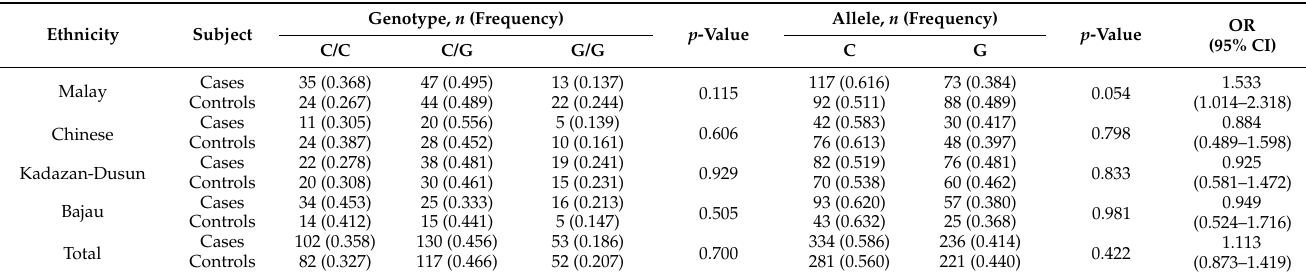
Table 2. Genotype and allele frequencies of the SLC1A2 rs4755404 polymorphism in male